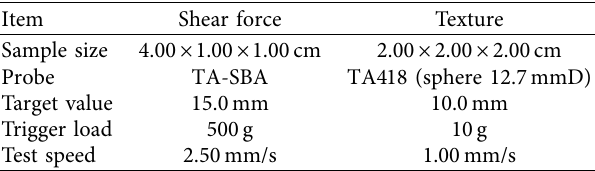
Table 1: Instrumental conditions of the texture analyzer. Item